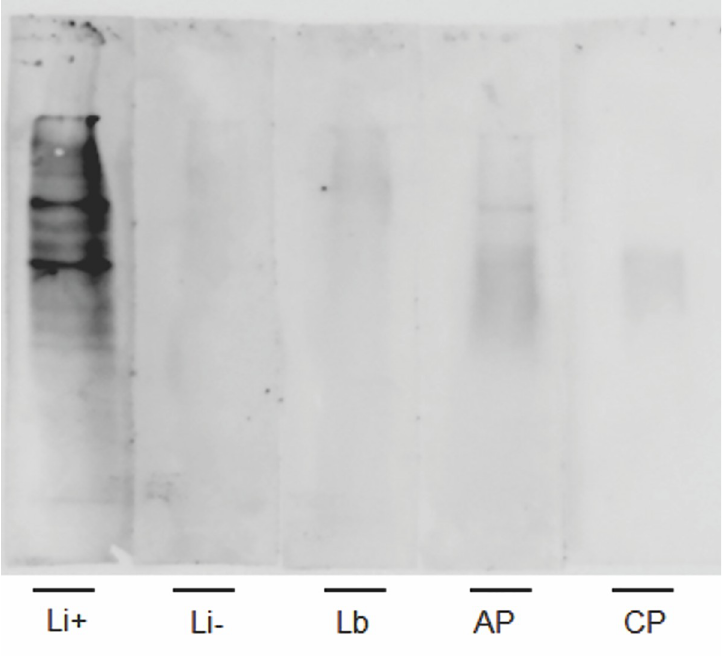
Fig 1. Recognition of LPG by a pool of serum samples taken from dogs with confirmed Leishmania infantum infection. The LPG solution was separated using a SDS-PAGE system, transferred to nitrocellulose paper and incubated with (Li+) a pool of serum samples from dogs with a confirmed L . infantum infection, (Li-) a pool of serum samples from non-endemic area dogs, a pool of serum samples from dogs with a confirmed L . braziliensis infection, and pools of serum samples that were experimentally infected with T . cruzi and in the (AP) acute phase or (CP) chronic phase of the